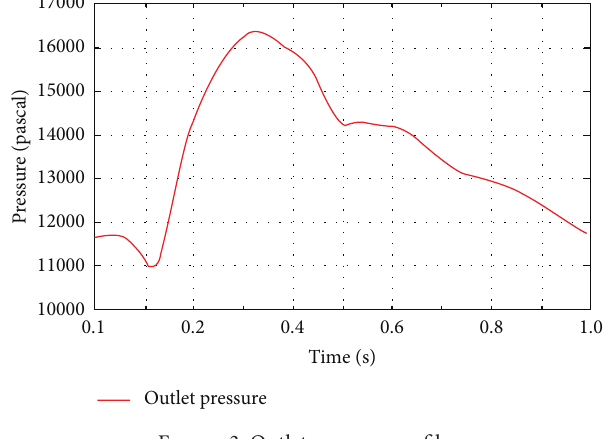
Figure 3: Outlet pressure profile.